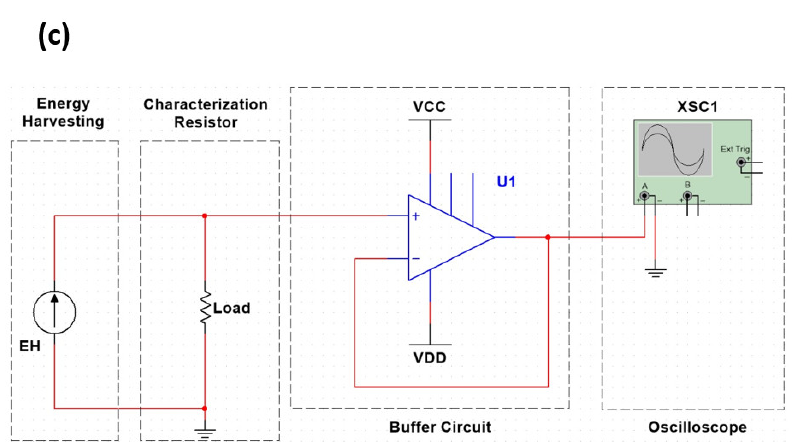
Figure 1. Design of the TENGs built in this work: ( a ) PDMS has the role of a spring material; ( b ) device containing a steel spring; ( c ) external circuit connected to the triboelectric